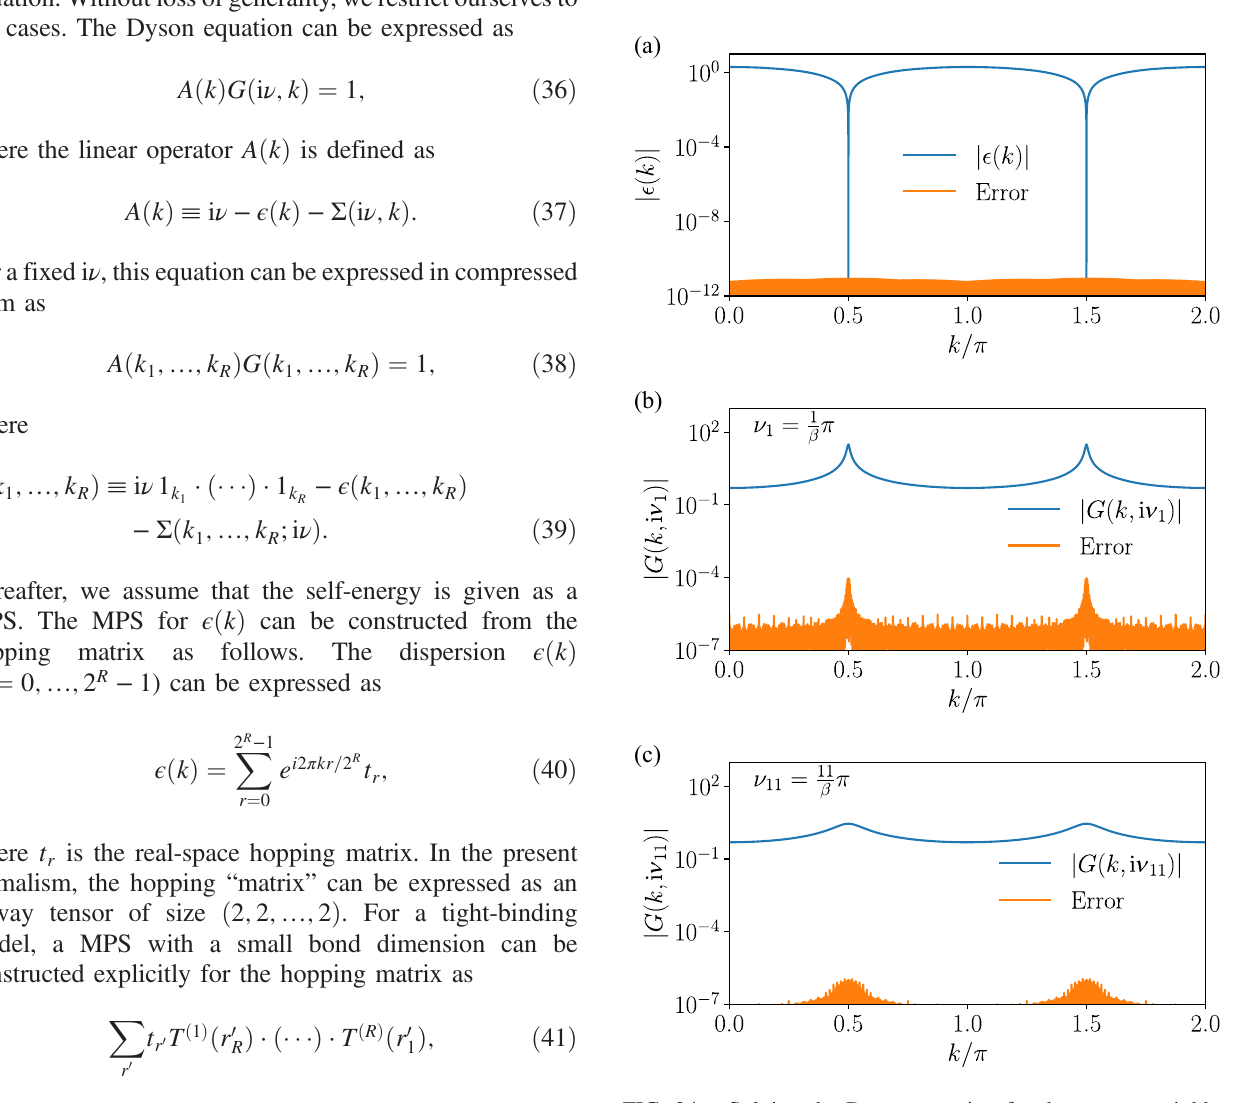
FIG. 24. Solving the Dyson equation for the nearest-neighbor tight-binding model on the 1D lattice for β ¼ 100 . (a) ϵ ð k Þ computed by Fourier transformation in the QTT form. (b) [(c)] Green ’ s functions computed for ν ¼ ð 1 = β Þ π [ ν ¼ ð 11 = β Þ π